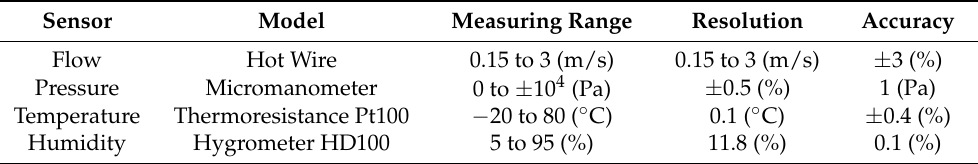
Table 4. KIMO AMI 300 Equipment Characteristics.